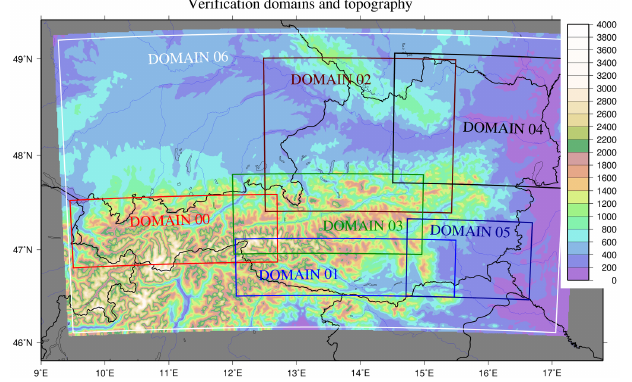
Figure 2. Verification domains numbered 00 through 06, and to- pography. Height in meters with color scale on the